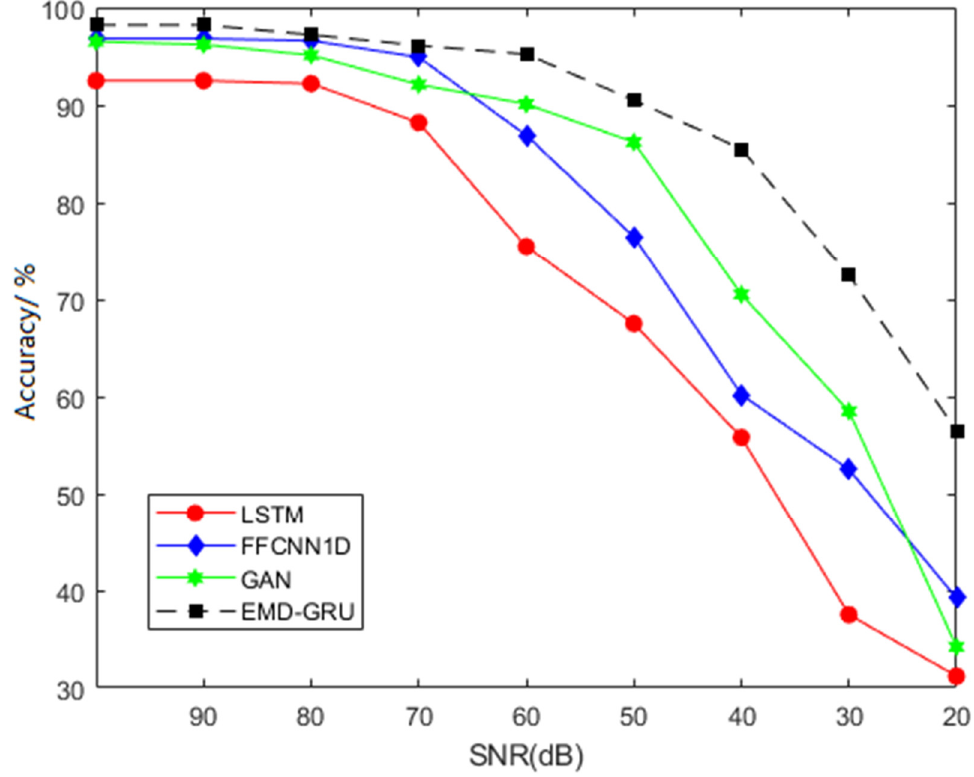
Figure 13. Comparison of the fault diagnostic methods in different noise environments.